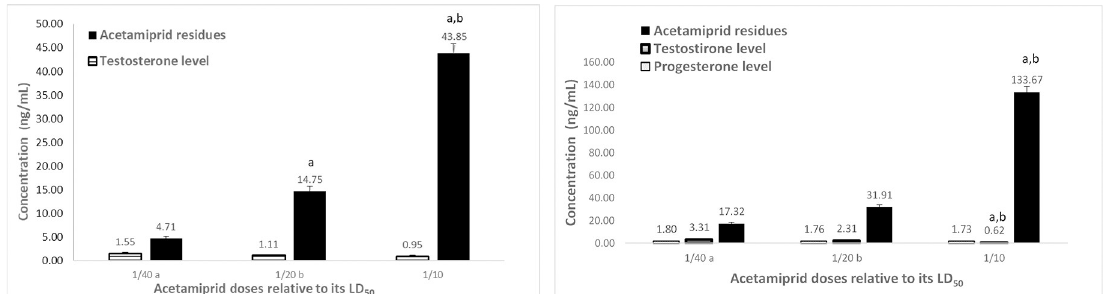
Fig 6. A. Serum testosterone levels and acetamiprid residues levels after a month of different acetamiprid doses treatment of the male rats. Data presented as mean S.E. a Significant difference as compared to 1/40 LD 50 , and b significant difference as compared to 1/20 of LD 50 (n = 4, P � 0.05). B. Serum testosterone and progesterone levels as well as acetamiprid residues after 2 months of different acetamiprid doses treatment of male rats. Data presented as mean S.E. a Significant difference as compared to 1/40 LD 50 , and b significant difference as compared to 1/20 of LD 50 (n = 4, P �